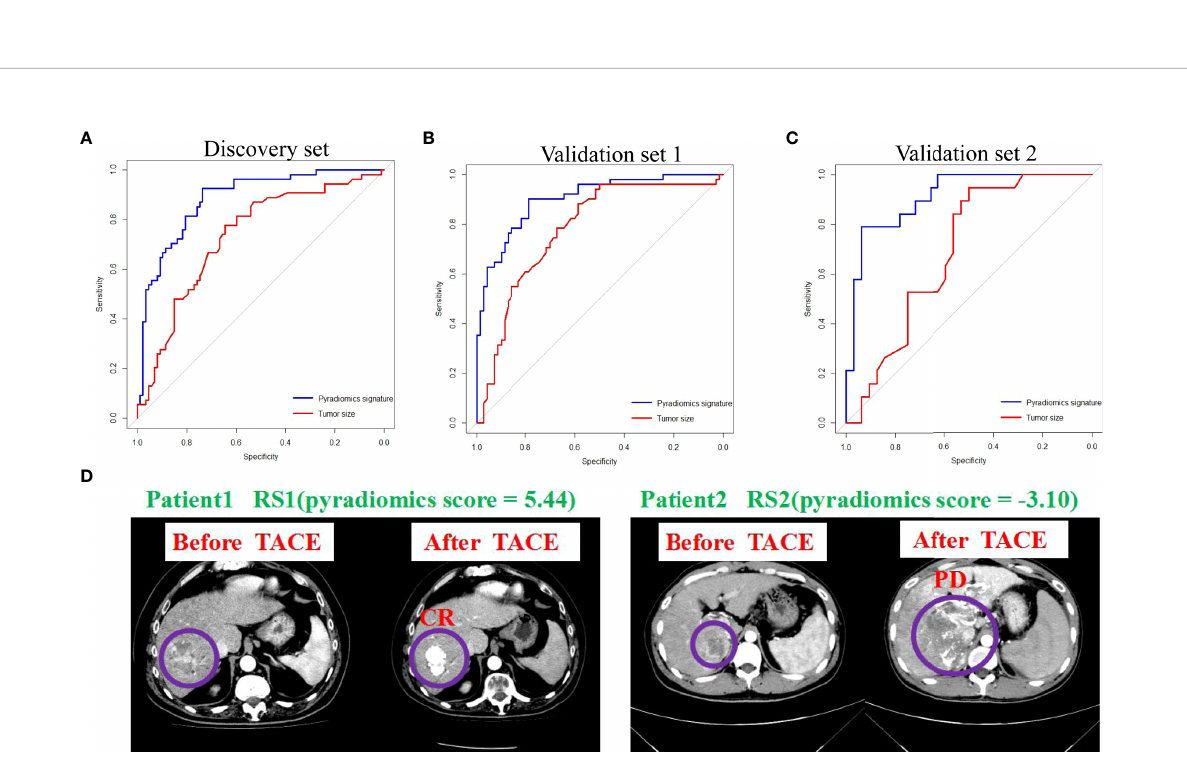
FIGURE 3 Pyradiomics signature and tumor size predict treatment response to TACE. (A-C) ROC curves show the predictive performance of pyradiomics signature and tumor size for estimating CR and PR. The bootstrap (n=2000) test results of the two ROC curves indicate that the AUC of the sum of pyradiomics signature is signi fi cantly higher than those of the tumor size in the discovery and in validation 1 and 2 sets. (D) Examples of two patients with response (RS1) or no response (RS2). ROC, receiver operating characteristic; AUC, area under curve; CR, complete response; PR, partial